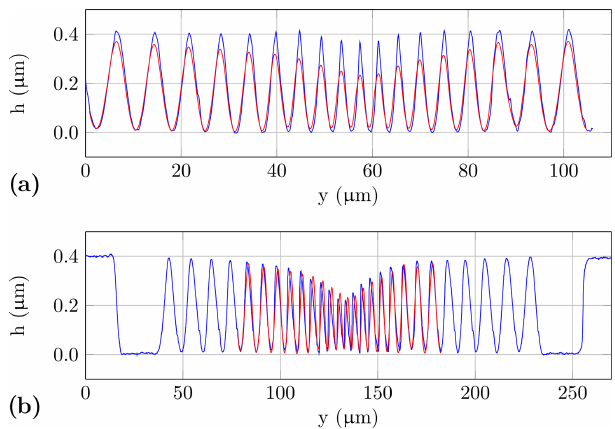
Figure 8. Comparison of different profiles of the fine chirp struc- ture: (a) profile measured by AFM (blue) and the same profile fil- tered with a sliding average filter based on a rectangular impulse response function with a pulse width of 1.85µm (red), and (b) com- parison of the filtered profile (red) from (a) and the structure mea- sured by the interferometric high-speed sensor